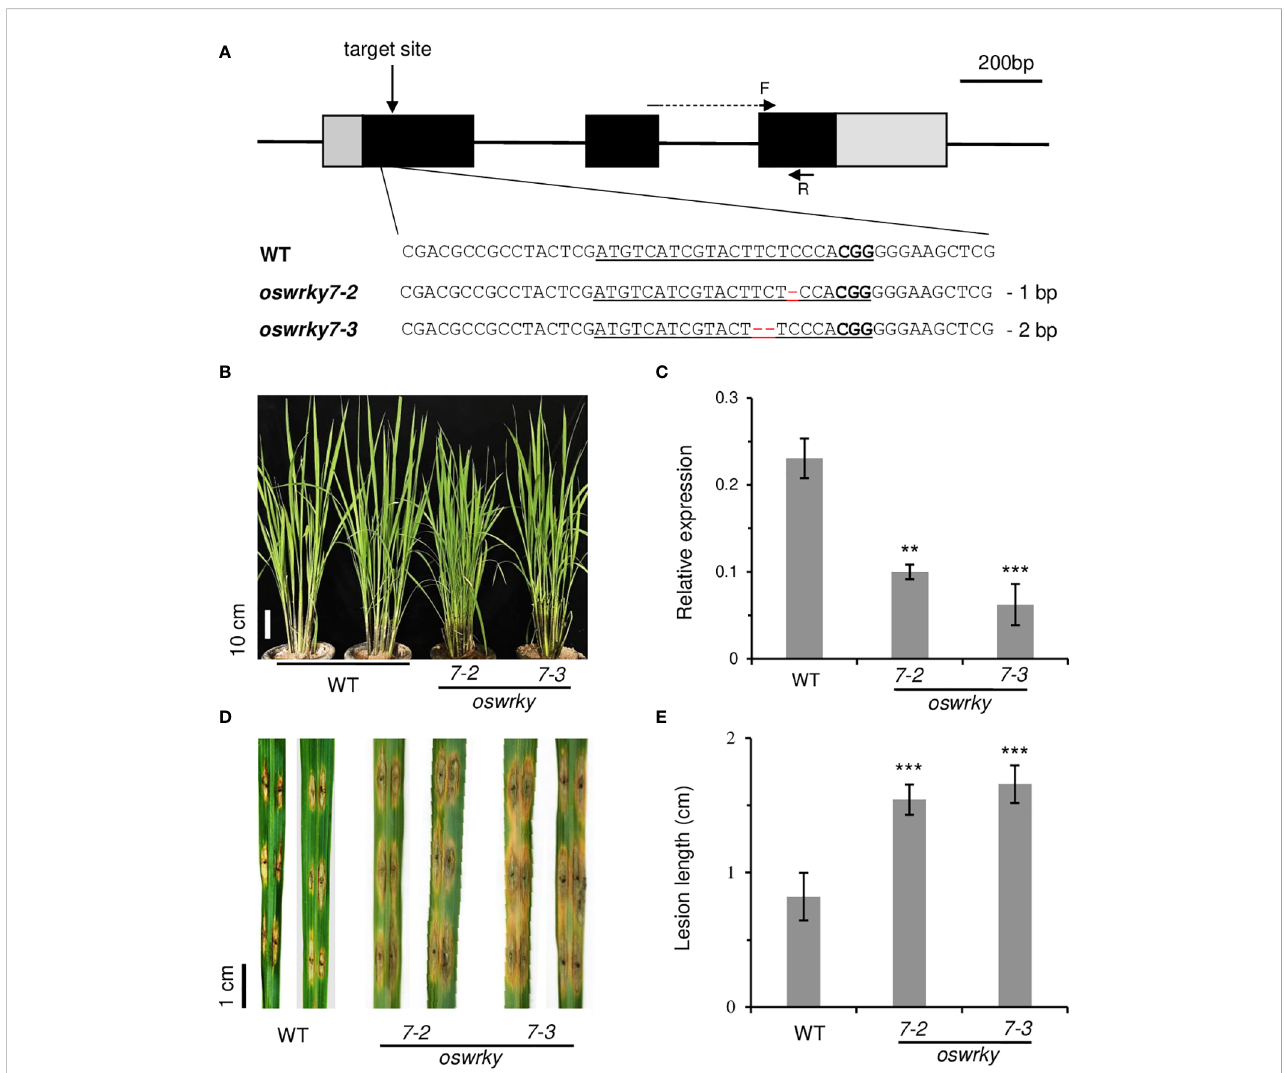
FIGURE 3 Characterization of oswrky7 mutants generated by the CRISPR/Cas9 method. (A) Schematic diagram of OsWRKY7 gene structure and sequence comparison of sgRNA target regions between WT and mutants. The target sequence and PAM site are underlined. Deleted sequences are indicated with red dashes. In the schematic gene structure, black boxes are exons; gray boxes are 5 ’ - UTR and 3 ’ -UTR regions; lines between the boxes are introns. F and R are primers used for measuring the transcript level of OsWRKY7 . Scale bar = 200 bp. (B) Phenotypes of the WT and the knockout mutant plants grown under the paddy fi eld at T1 generation. Scale bar = 10 cm. (C) Transcript level of OsWRKY7 in the WT and knockout mutant plants. Samples were collected at 42 DAG (D) Comparison of the lesions between the WT and mutants. Phenotype was observed at 9 days after M. oryzae infection. Scale bar = 1 cm. (E) The length of the lesion developed by the pathogen. The error bars show standard deviations; n = 10. Statistical signi fi cance is indicated by **(P < 0.01) and ***(P <